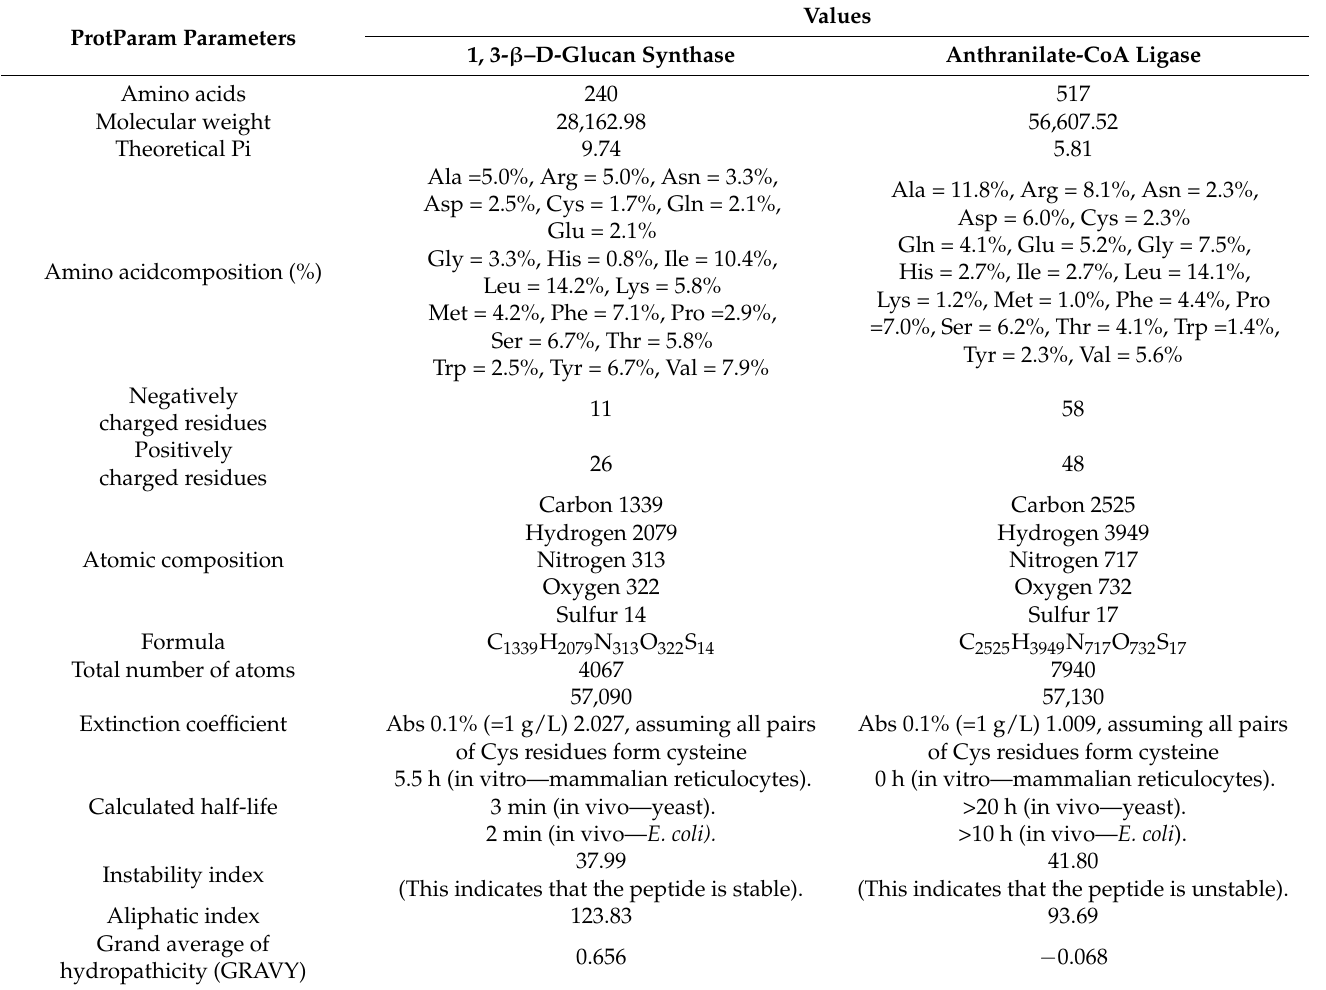
Table 2. Physicochemical parameters of 1, 3- β –D-glucan synthase and Anthranilate-CoA ligase investigated in this